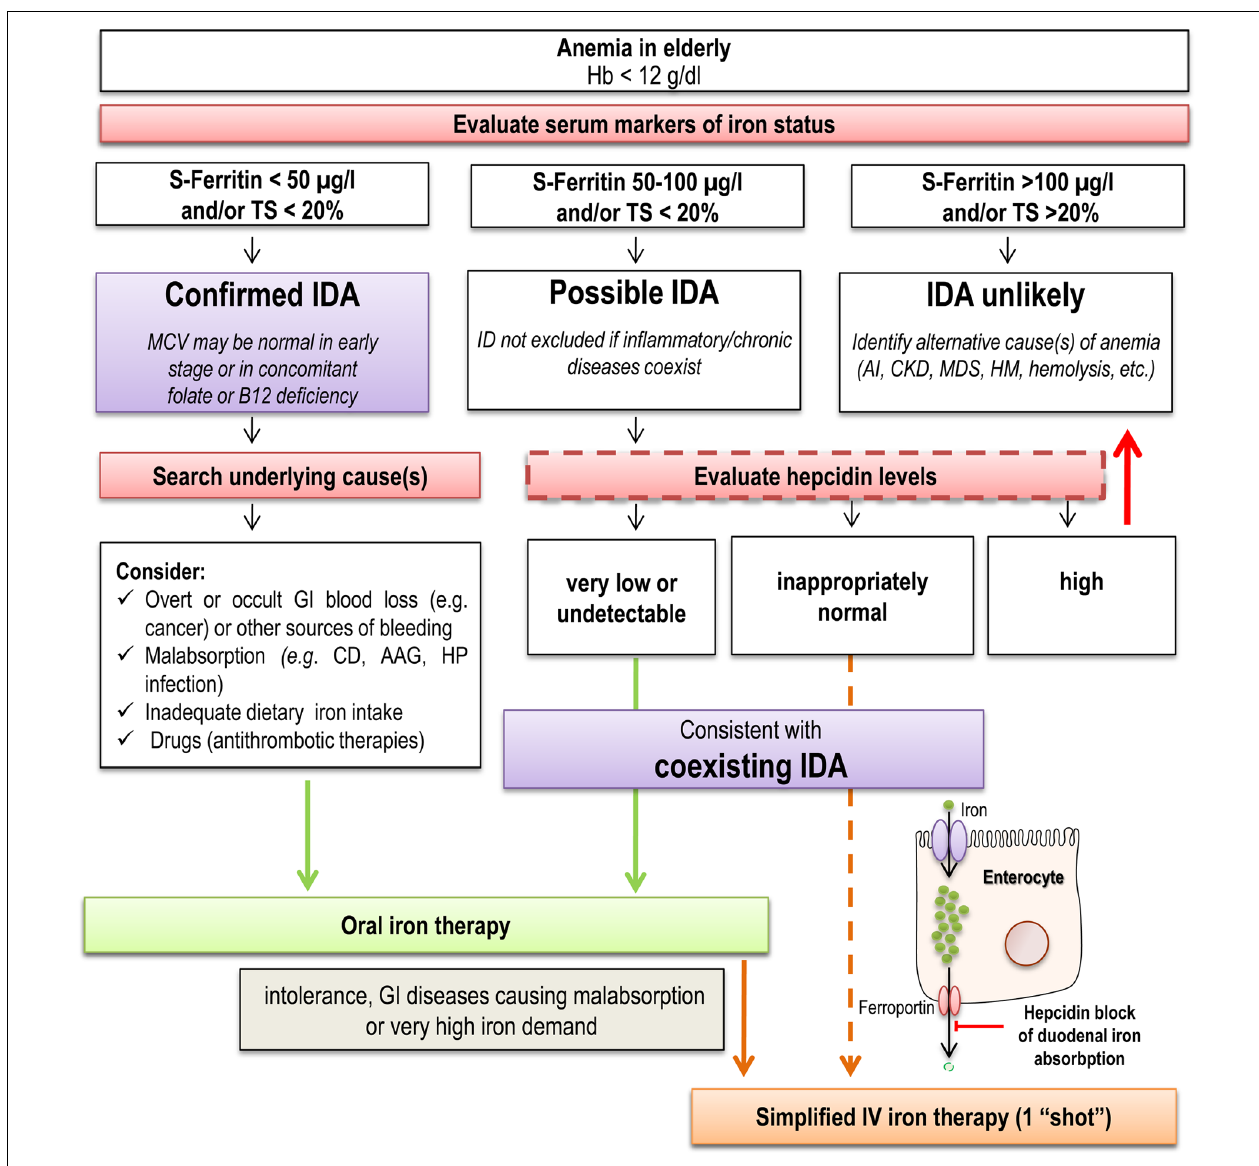
clinical practice, a better standardization of hepcidin assays is needed. AAG, autoimmune atrophic gastritis; AI, anemia of inflammation; CD, celiac disease; CKD, chronic kidney disease; GI, gastrointestinal; Hb, hemoglobin; HM, hematologic malignancies; HP, Helicobacter pylori; IDA, iron deficiency anemia; MDS, myelodysplastic syndrome; TS, transferrin